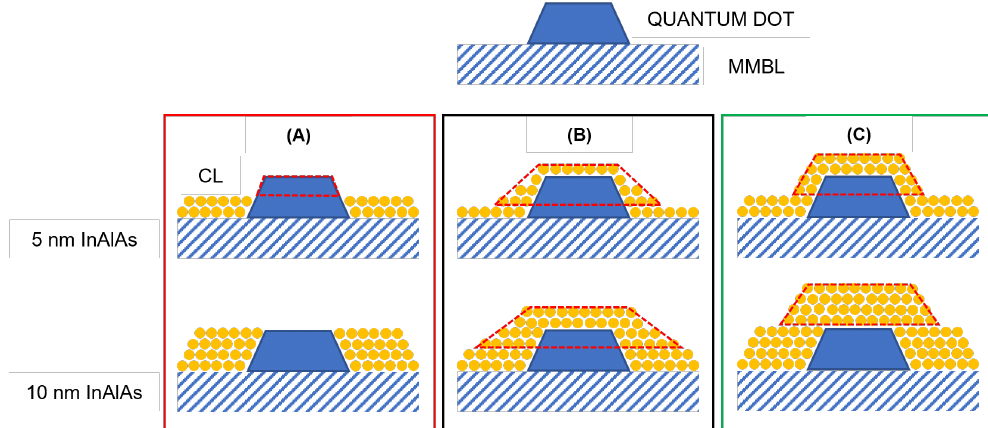
Figure 4. Graphical models of a QD covered by 5 and 10 nm CL ( A ) as if all the dots were pseudomor- phic (PQD model); ( B ) as if material accumulations occurs on the dot due to a mass transfer mecha- nism; ( C ) as if the entire surface is covered by a CL of uniform thickness (CC model). The dashed red line marks the volume of the QDs that would be detected by AFM. ( A ) QD height decreases by an amount equal to the CL thickness. ( B , C ) QD height as seen by the AFM is constant.